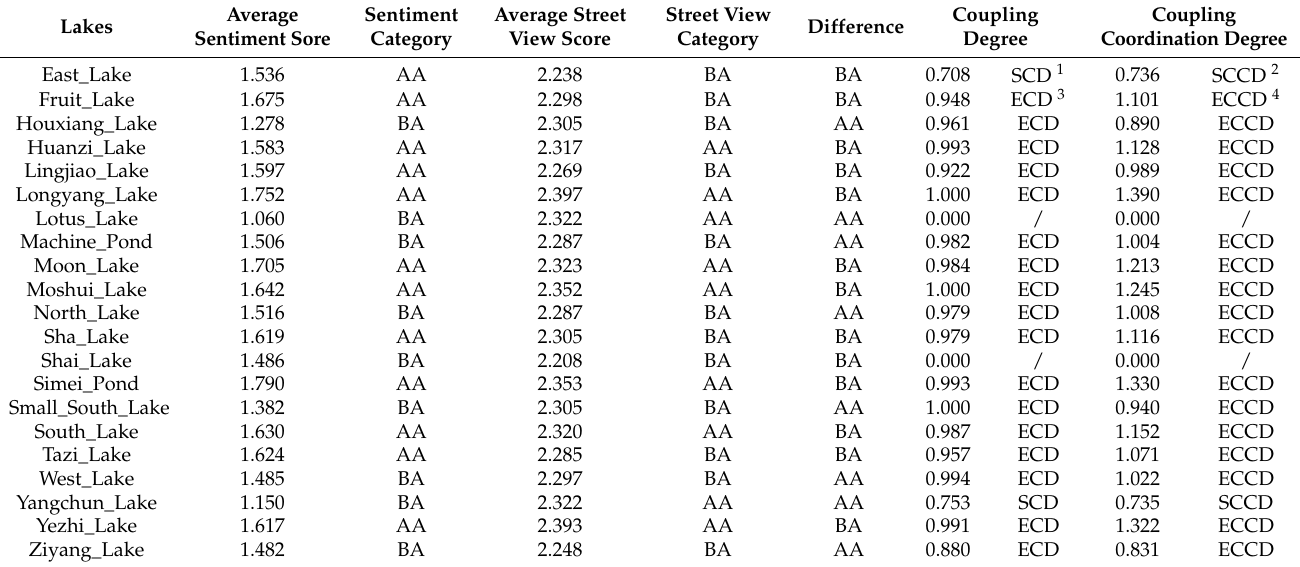
Table 9. Characteristics in spatial quality and public sentiment in each lakefront